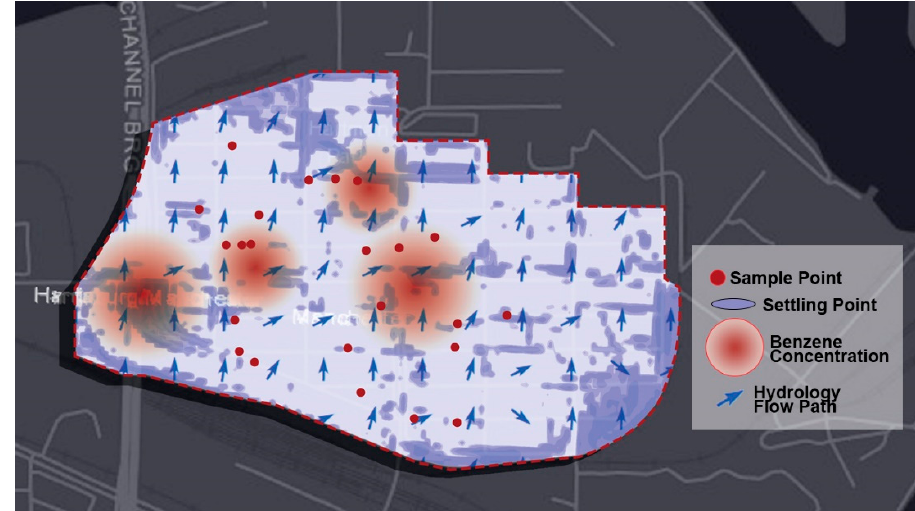
Figure 2. Geocoded sampling points, water settling points, and major benzene concentrations in Manchester, TX.